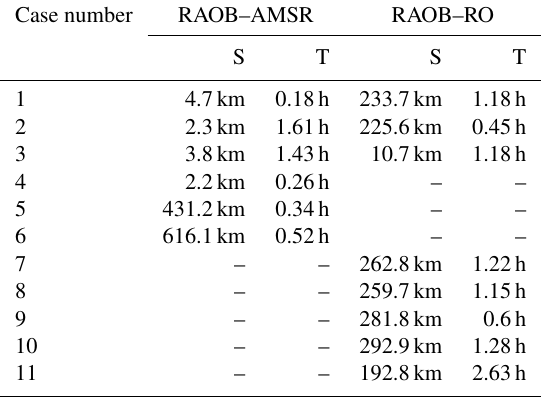
Table 1. The spatial and temporal distance between different obser- vation methods for each collocated case analyzed in this paper. The RAOB–AMSR column shows the differences between the RAOB and its closest AMSR-E measurement location in the simulation re- sults, while the RAOB–RO column shows the differences between the actual RO tangent point location and its closest RAOB measure- ment. The RAOB observations in cases 1 to 3 are repeated in both the simulation and the actual data analysis.